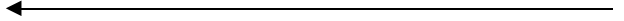
Fig. 6. 4 (cid:112) electron distributions at four selected energies between 53.21 and 301.25 eV in the LLBL on 17 September 1995, from 04:26:13 to 04:28:13 UT. The vertical axis gives the polar angle varying from the solar direction (+90 (cid:176) ) to the anti-solar direction ( ) 90 (cid:176) ); the horizontal axis is the rotation angle. The satellite spin axis is pointing towards the Sun and the 180 (cid:176) detector field of view contains the spin axis. The blue crosses indicate the magnetic-field direction, the white crosses the direction anti-parallel to the magnetic field